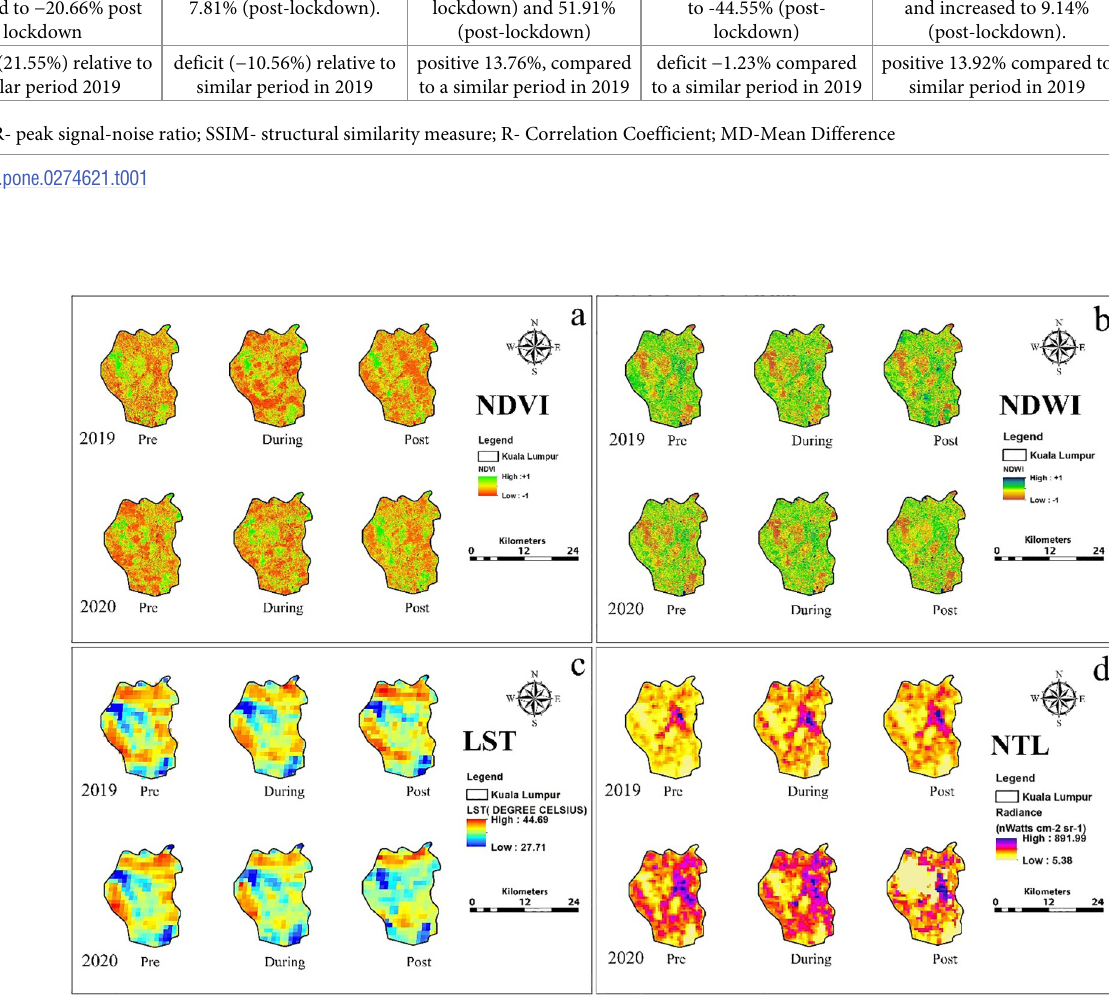
Fig 1. Spatio-temporal changes in a) NDVI, b) NDWI, c) LST and d) NTL based on the thematic maps of the Kuala Lumpur